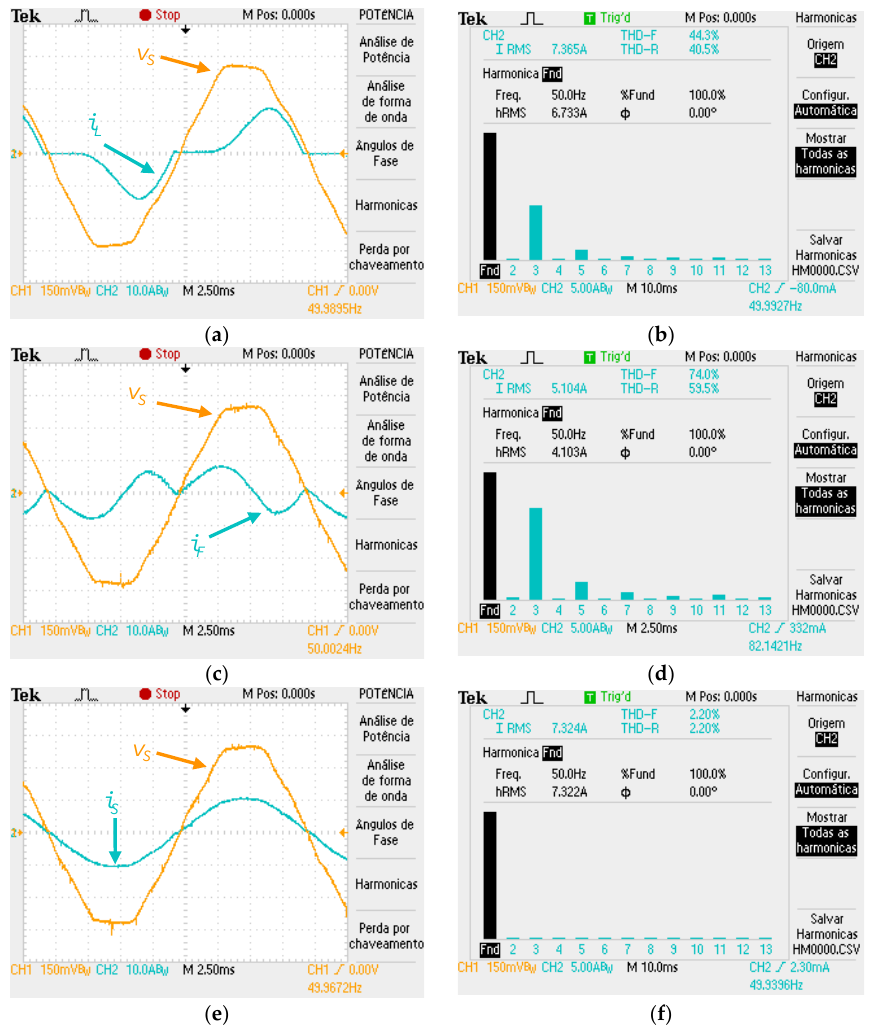
Figure 28. Experimental results of the SAPF with a Resistive-Capacitive (RC) load and a rectifier: ( a ) Source voltage ( v S ) and load current ( i L ); ( b ) Harmonic spectrum of the load current ( i L ); ( c ) Source voltage ( v S ) and SAPF current ( i F ); ( d ) Harmonic spectrum of the SAPF current; ( e ) Source voltage ( v S ) and source current ( i S ); ( f ) Harmonic spectrum of the source current ( i S ).